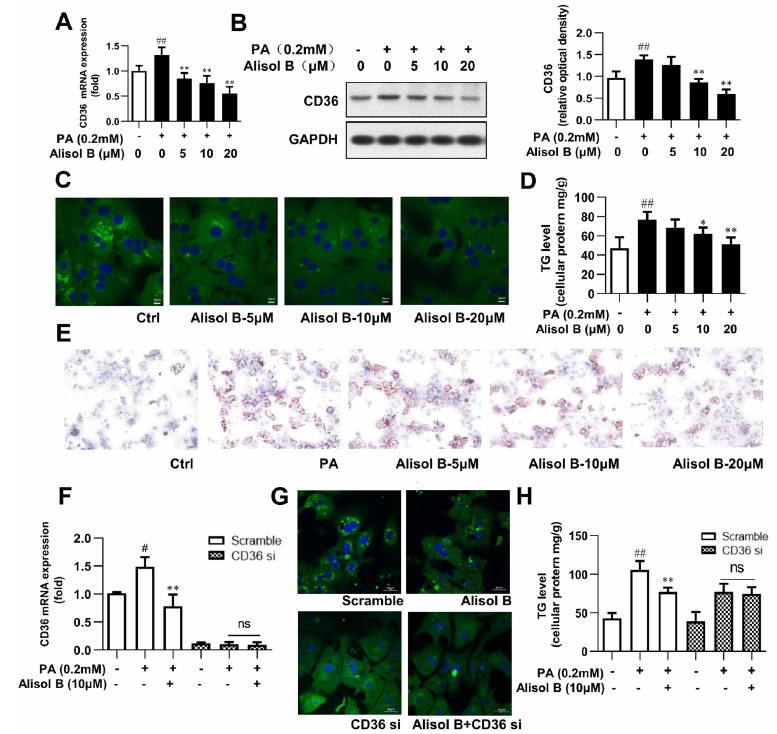
Figure 4. Alisol B ameliorated cellular TG accumulation in primary hepatocytes by inhibiting FFA uptake in a CD36-dependent manner. Mouse primary hepatocytes were incubated with indicated concentration of Alisol B under PA (0.2 mM)-stimulated condition. ( A ) RT-PCR analysis and ( B ) Western blot analysis of CD36 expression, ( C ) BODIPY-C16 fluorescence (600 × magnification), ( D ) cellular TG, and ( E ) Oil Red O staining (200 × magnification) were conducted. ( F – H ) Primary hepatocytes were pretreated with CD36 siRNA for 24 h and then treated with Alisol B (10 µ M) under PA-induced conditions. ( F ) CD36 mRNA level, ( G ) BODIPY-C16 fluorescence (600 × magnification), and ( H ) cellular TG were examined. Data are expressed as mean ± SD, n = 5. # p < 0.05, ## p <